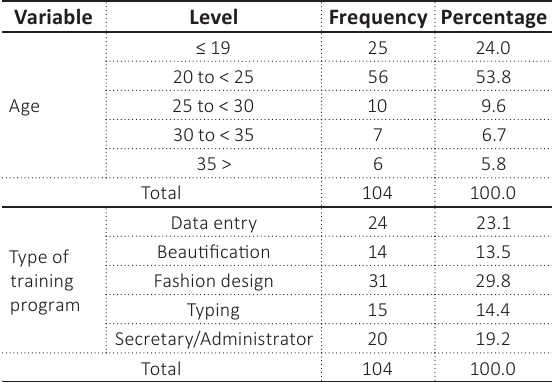
Table 1. Distribution of participants by